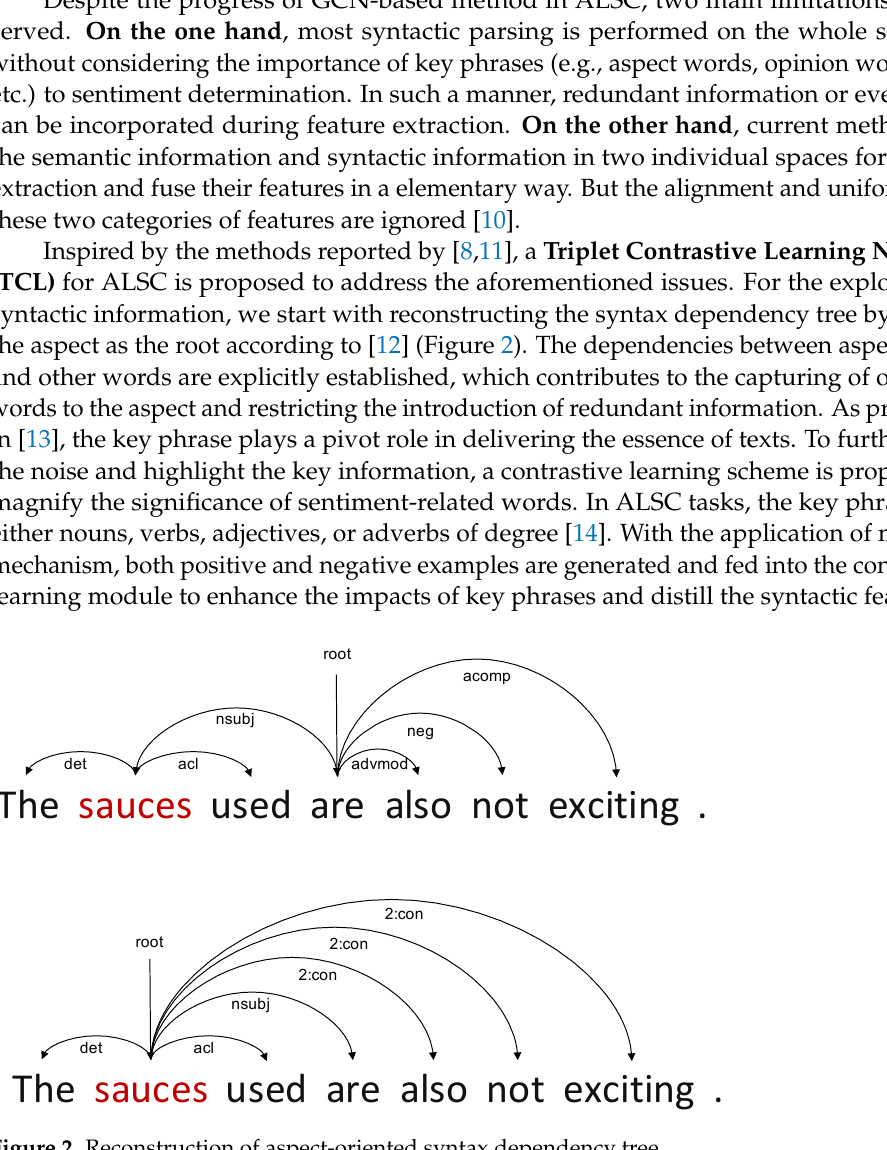
Figure 1. An example of ALSC.